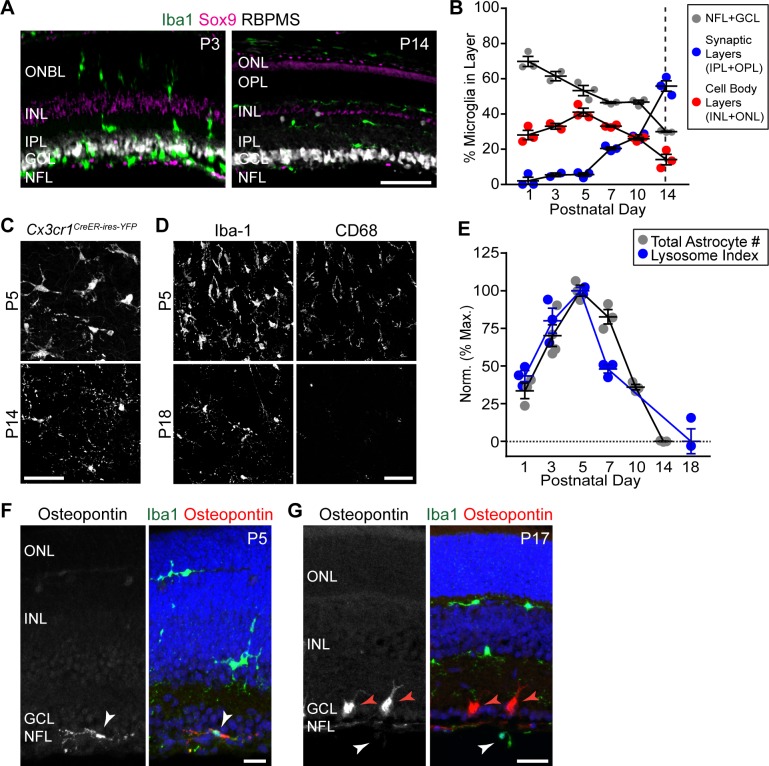
Nerve fiber layer microglia express a phagocytic phenotype during the astrocyte death period.(A,B) Retinal microglia localize preferentially to RNFL until the end of the astrocyte death period at P14 (dashed line). (A) Representative retinal sections showing laminar location of Iba-1+ microglia; (B) microglial laminar location quantified across development in whole-mount images (e.g., C). (C) RNFL microglia visualized in Cx3cr1CreER-ires-YFP whole-mount using anti-GFP. Microglia show amoeboid morphology during the astrocyte death period (P5) but ramified morphology once death is complete (P14). (D) RNFL microglia (labeled with anti-Iba-1) have high lysosomal content (anti-CD68) at the peak of the astrocyte number (P5). CD68 is largely absent after the death period (P18). (E) Quantification of microglial phagocytic capacity, measured using a lysosome index (CD68+ lysosome content per microglial cell; blue). Gray, total astrocyte numbers, replotted from Fig 1G for comparison. Note the strong correlation between these measures, both during arrival of astrocytes in retina (P1–P5; see Fig 1A) and during their elimination (P5–P14). (F,G) During the death period, RNFL microglia (white arrows) are molecularly distinct from Iba-1+ microglia in other layers, as shown by their expression of Osteopontin at P5 (F) but not P17 (G). Red arrows, Osteopontin+ RGCs [48]. Error bars, mean ± SEM. Sample sizes are depicted by data points on graph. For data plotted in graphs, see S1 Data. Scale bars, 50 μm (A,C,D); 20 μm (F,G). GCL, ganglion cell layer; GFP, green fluorescent protein; INL, inner nuclear layer; IPL, inner plexiform layer; NFL, nerve fiber layer; ONBL, outer neuroblast layer; ONL, outer nuclear layer; OPL, outer plexiform layer; RGC, retinal ganglion cell; RNFL, retinal nerve fiber layer.